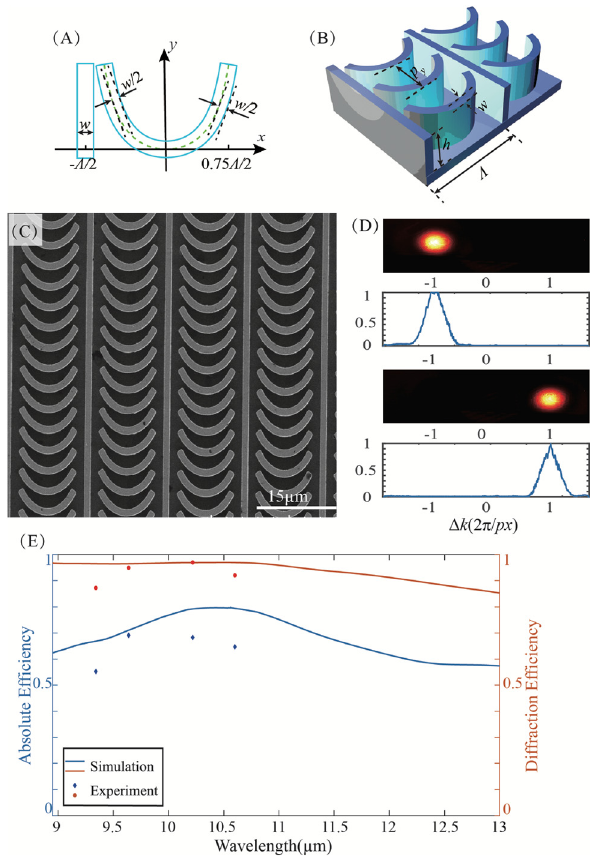
Figure 2: (A, B) 2D and 3D schematic views of the integral structure with an equal width. The geometric parameters are as follows: w = 1.3 μ m and h = 4.7 μ m. (C) Scanning electron microscopy (SEM) image of the de fl ector sample. The lattice spacings of the array are Λ =14.99 μ mand p μ m.(D)Experimentalmeasurementresults y =3.2 under LCP (top) and RCP (bottom) illumination at the wavelength of 10.6 μ m. (E) Simulated and measured results of absolute and diffraction ef fi ciencies over a broad spectrum from 9 to 13 μ